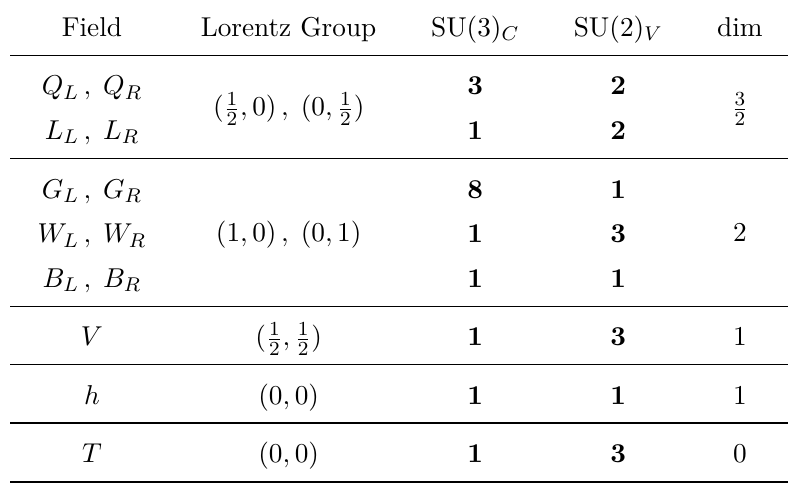
Table 5 . ( ν )HEFT field representations under spacetime and internal symmetry groups when the U(1) is promoted to the custodial symmetry SU(2) EM is an SU(2) adjoint that would break it down to its Cartan subgroup U(1) V